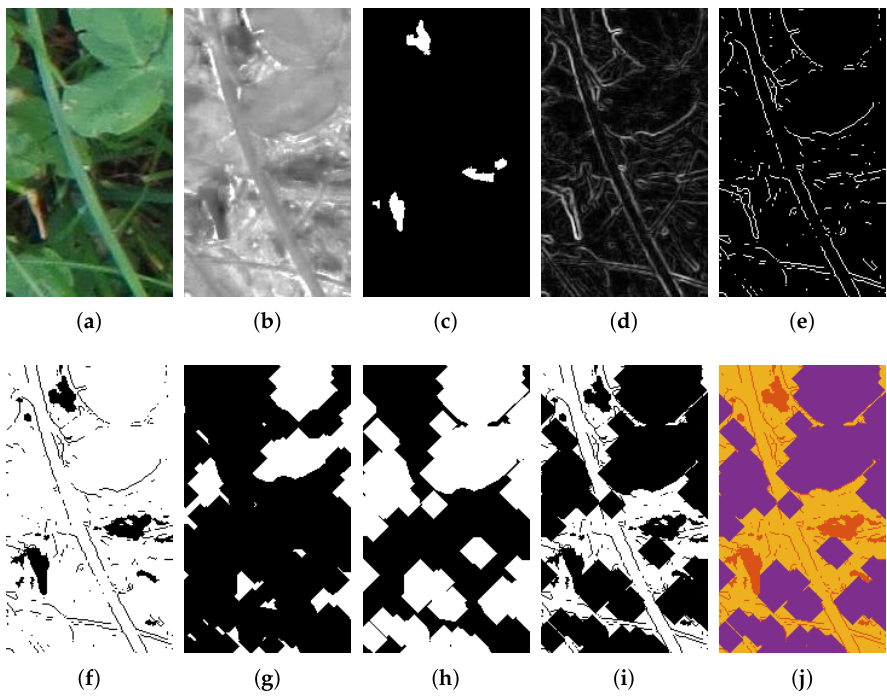
Figure 4. Example of clover and grass segmentation using the original method proposed by Bonesmo et al. [6]. ( a ) Original image captured in indirect sunlight; ( b ) soil green-red ratio image; ( c ) threshold soil image; ( d ) Sobel gradient image; ( e ) edge image; ( f ) segmented image prior to erosion; ( g ) segmented image after the erosions; ( h ) reconstructed clover image using dilation; ( i ) grass image; ( j ) classification image. Yellow = grass. Purple = clover. Red = soil/dead plants. More recent work by Meyer and Neto [30] has shown that the difference ( ExGR ) in excess green ( ExG ) and excess red ( ExR ) is a good color vegetation index for distinguishing soil and dead